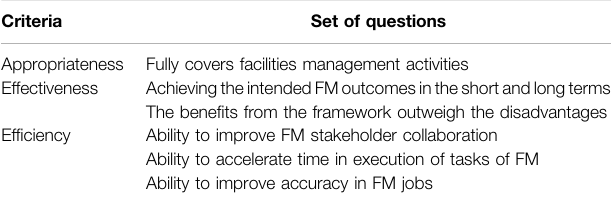
TABLE 3 | Interview set of questions. Criteria Set of